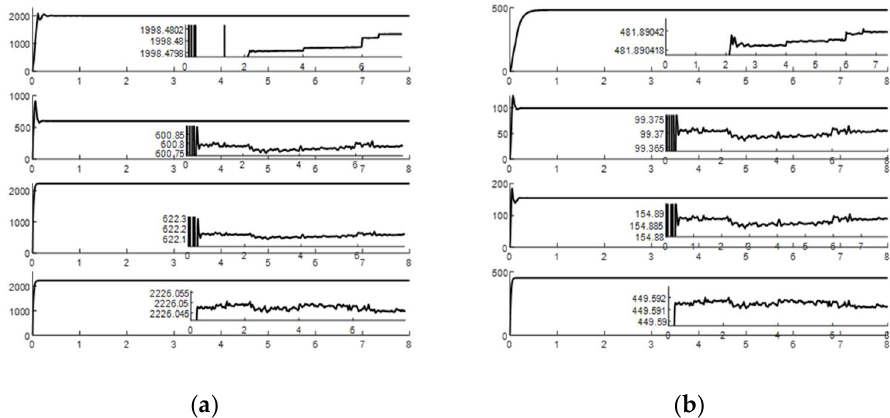
Figure 9. k p and k d adaptive values: ( a ) k p adaptive value; ( b ) k d adaptive Figure 9.